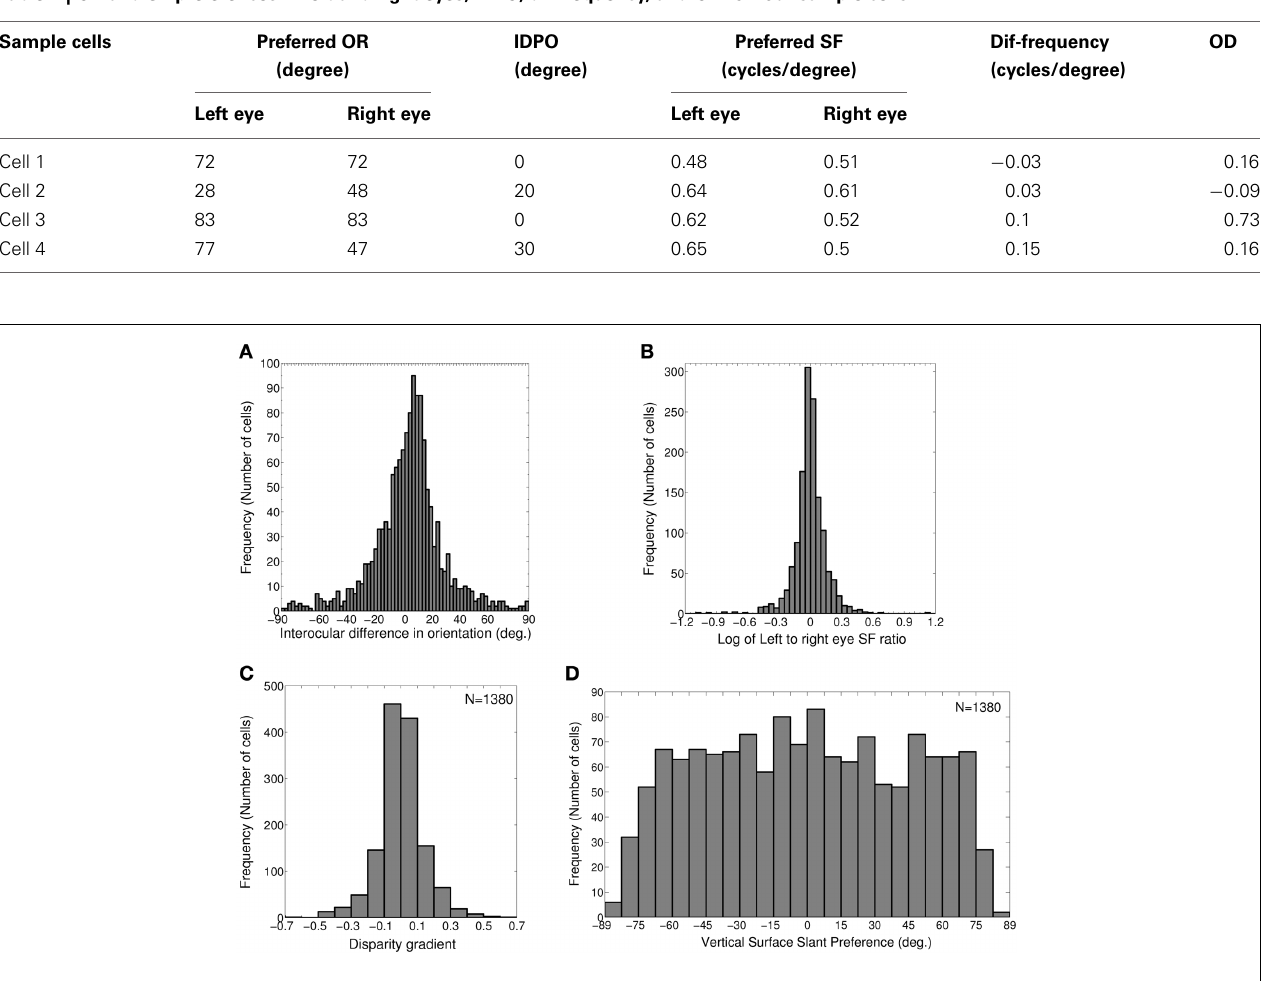
FIGURE 2 | IDPO, left to right eye SF ratio, Disparity gradient and Vertical surface slant preference. (A) Histogram of IDPOs in degrees. 73.4% of cells have IDPOs in the range of ± 20 ◦ ( S = 8 . 9 ◦ ). Rest of the cells has significant IDPOs ( | IDPO | > 20 ◦ ). (B) Histogram of log of monocular left to right eye SF ratio for 1380 modeled cells with matched OR preferences in the two eyes.